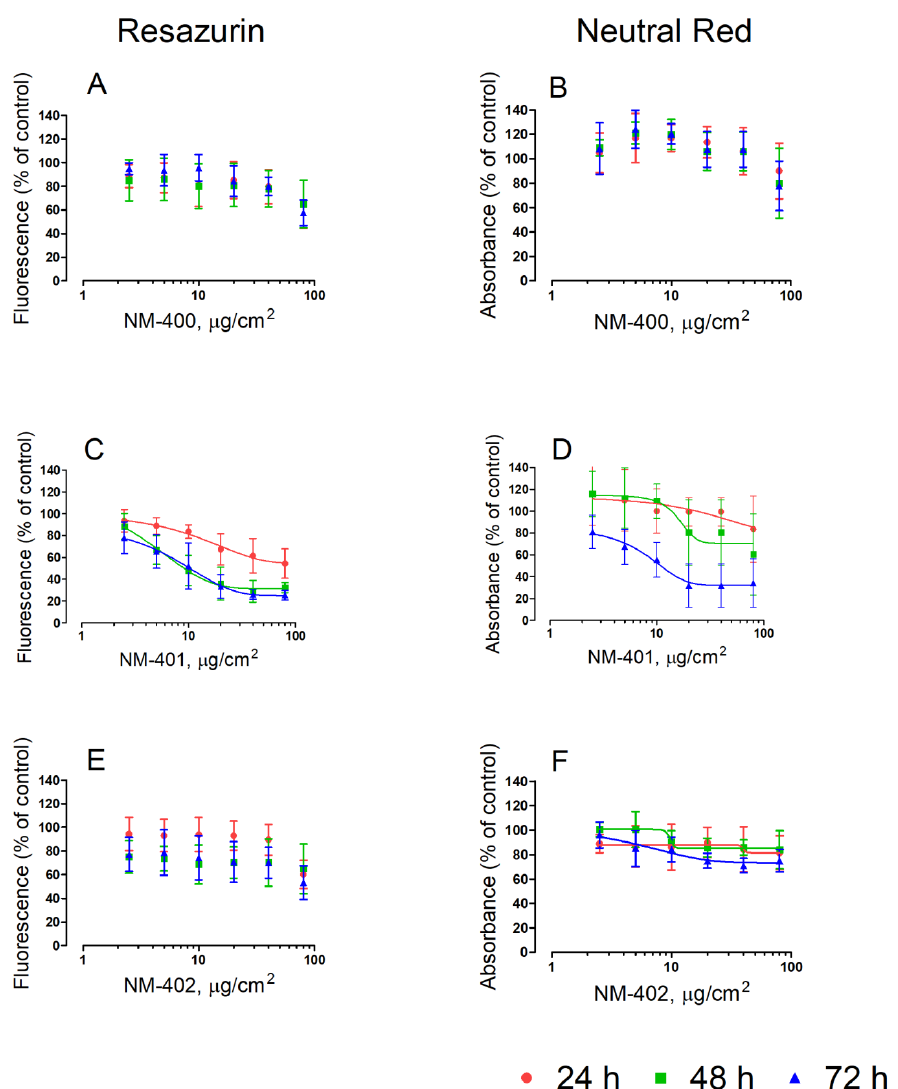
Figure 2. Effects of MWCNT on MH-S murine macrophages. Cells were grown for 24 h in complete growth medium and then exposed for 24 h, 48 h, and 72 h to the indicated doses of MWCNT. At the end of the incubation, cell viability was assessed with resazurin ( A , C , E ) or neutral red uptake assays ( B , D , F ). Data are the means ± SD of five independent determinations. Lines represent the best fit to the dose-response curve (variable slope). For the dose-response curves with NM-401, the R 2 values were 0.990, 0.995, and 0.995 at, respectively, 24 h, 48 h, and 72 h (resazurin); and 0.936 and 0.972 at, respectively, 48 h and 72 h (neutral red).